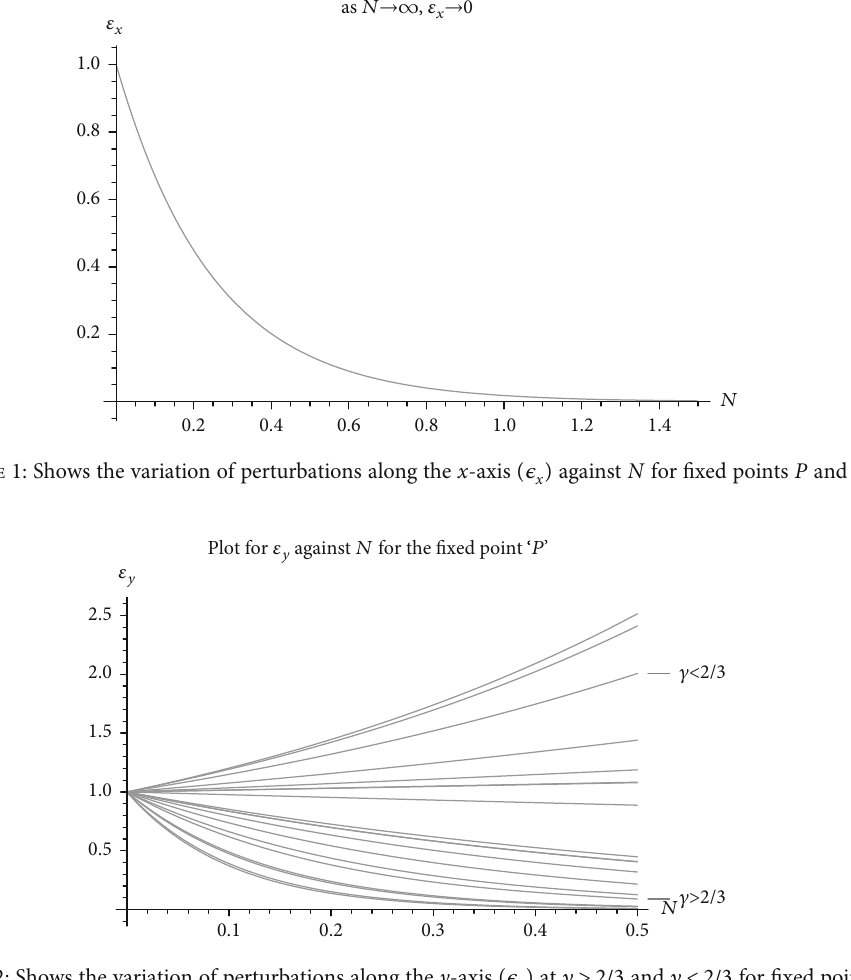
Figure 2: Shows the variation of perturbations along the y -axis ( ϵ